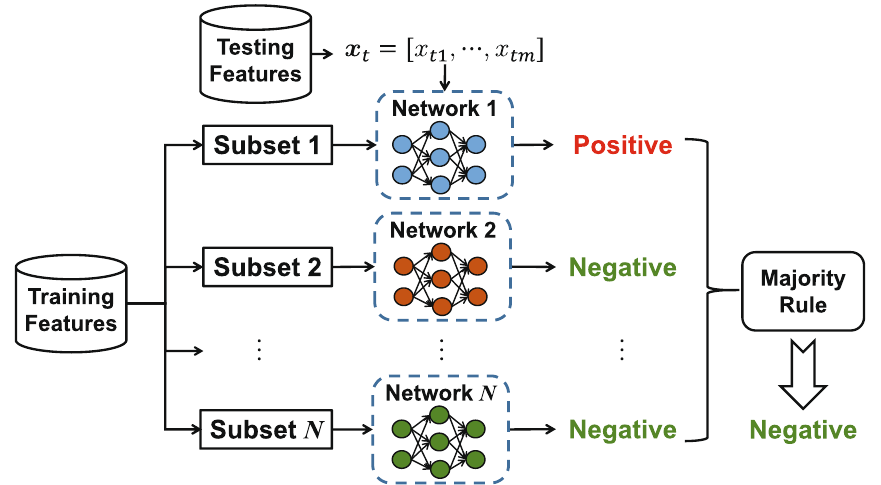
Figure 3. Concrete schematic of bagging dynamic learning network classifier in Fig. 1. N dynamic learning networks trained by N different types of subsets randomly under-sampled from training features predict the class to which testing images belong, and the final diagnosis result based on these predictions for the testing sample x t = [ x t 1 , . . . , x tm ] ∈ R 1 × m is determined by the majority rule.